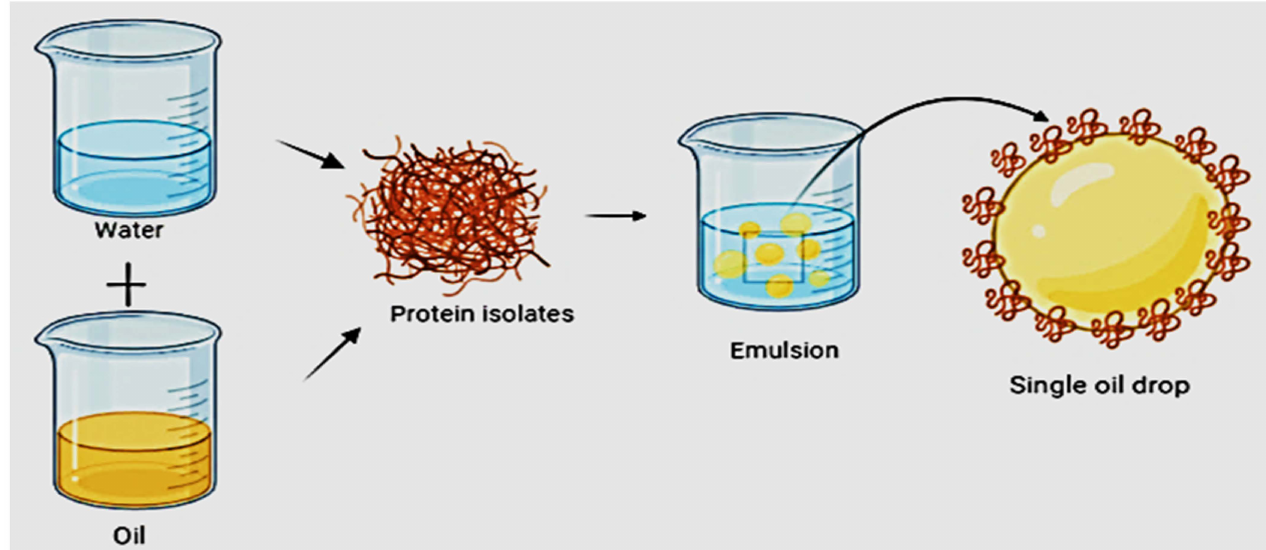
Figure 4. The symbolic presentation of emulsifying behavior of rice protein with the newly formed dispersed particle in the protein-mediated